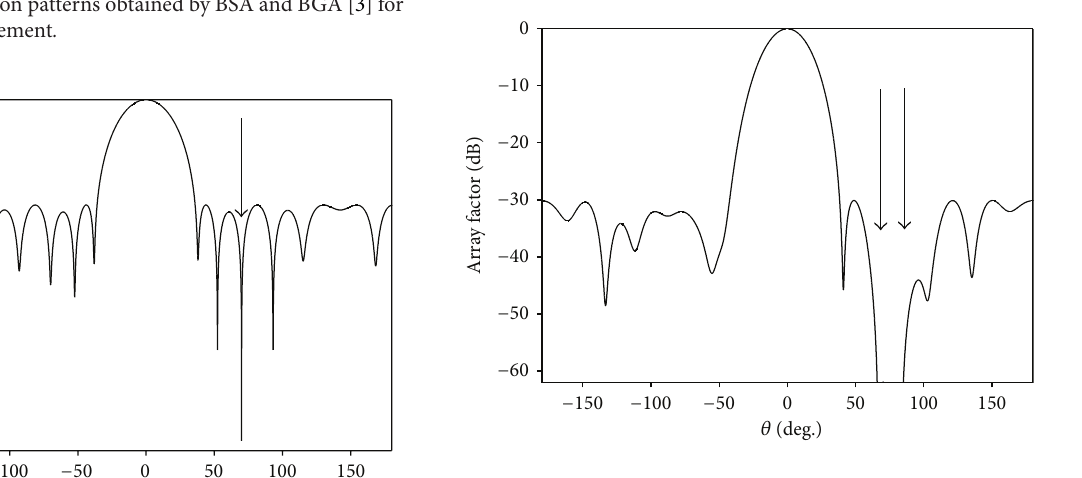
Figure 21: Radiation pattern obtained by amplitude-only control with a broad null sector centered 75 ∘ with Δ𝜃 = 10 ∘ . Table 3: MSLL, FNBW, and DRR values obtained by BSA and